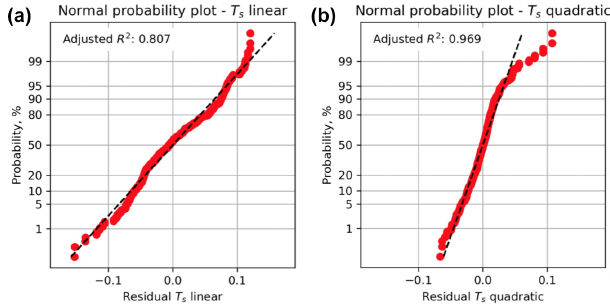
Figure 3. Residual plots for linear and quadratic response surfaces for slip tendency ( T s ) using synthetic data from worked exam- ple one. The quadratic fit has a higher value of the adjusted R 2 parameter and is therefore deemed to be better in this